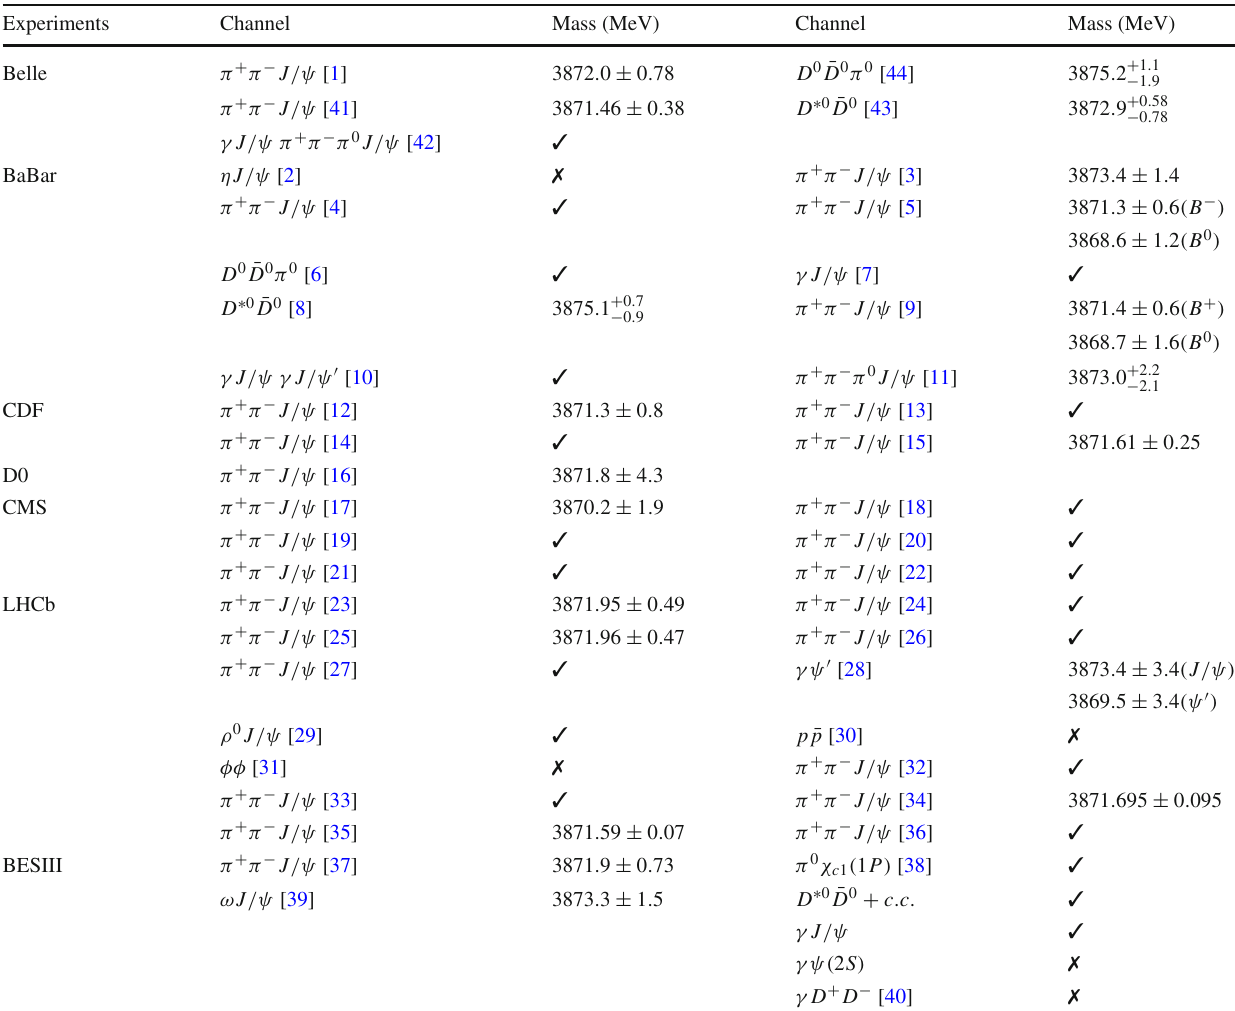
Table 1 The experimental measurements of X ( 3872 ) from different experiments, where ✓ denotes that the decay channel was observed but the mass of X ( 3872 ) was not reported and ✗ indicates that channel was not observed Experiments Channel Mass